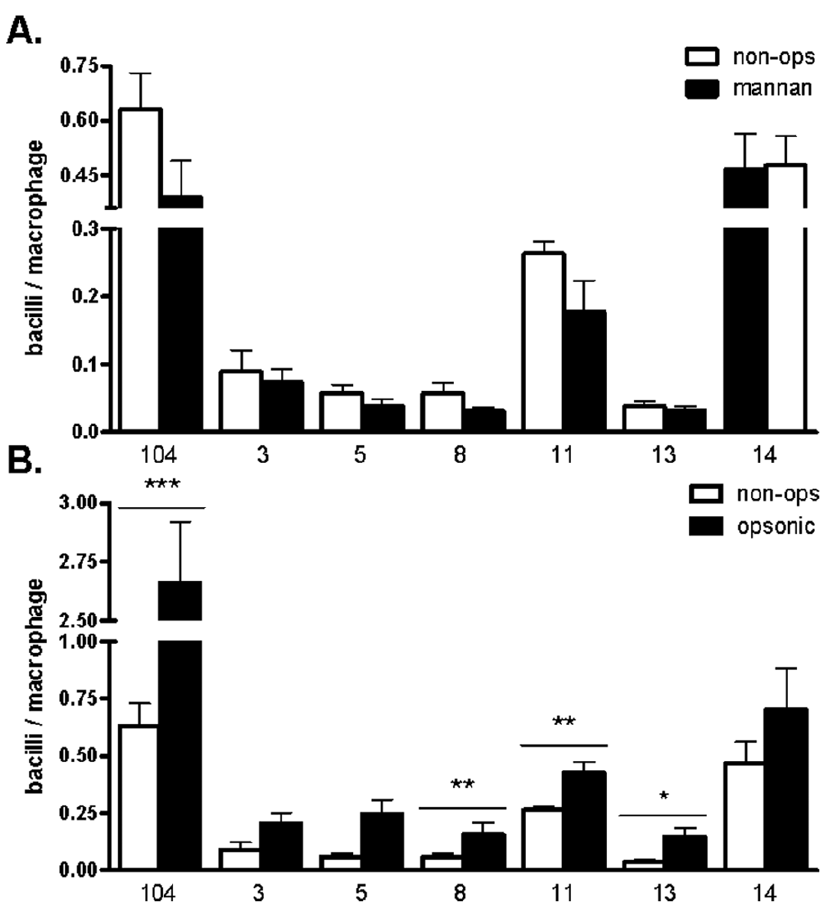
Figure 6. Association of M.avium spp. isolates with human macrophages. A. Non-opsonic condition. Macrophage monolayers (2.0 6 10 5 cells/ well) on glass coverslips in triplicate were incubated in the absence of serum with isolates (MOI 25:1) for 2 h at 37 u C, 5% CO 2 . MR-specific association was measured in the presence (close bars) of mannan (2.5 mg/ml). B. Opsonic condition. Macrophage monolayers were incubated with isolates as described above and association assessed in the absence (open bars) or presence (close bars) of 10% fresh autologous non-immune serum. Bacteria associated with macrophages were stained with rhodamine-auramine and association assessed by phase- contrast and fluorescence microscopy. . 300 cells/coverslip were counted. Shown are cumulative data from N=3 (mean 6 SEM) *P , 0.05, *P , 0.01, ***P ,